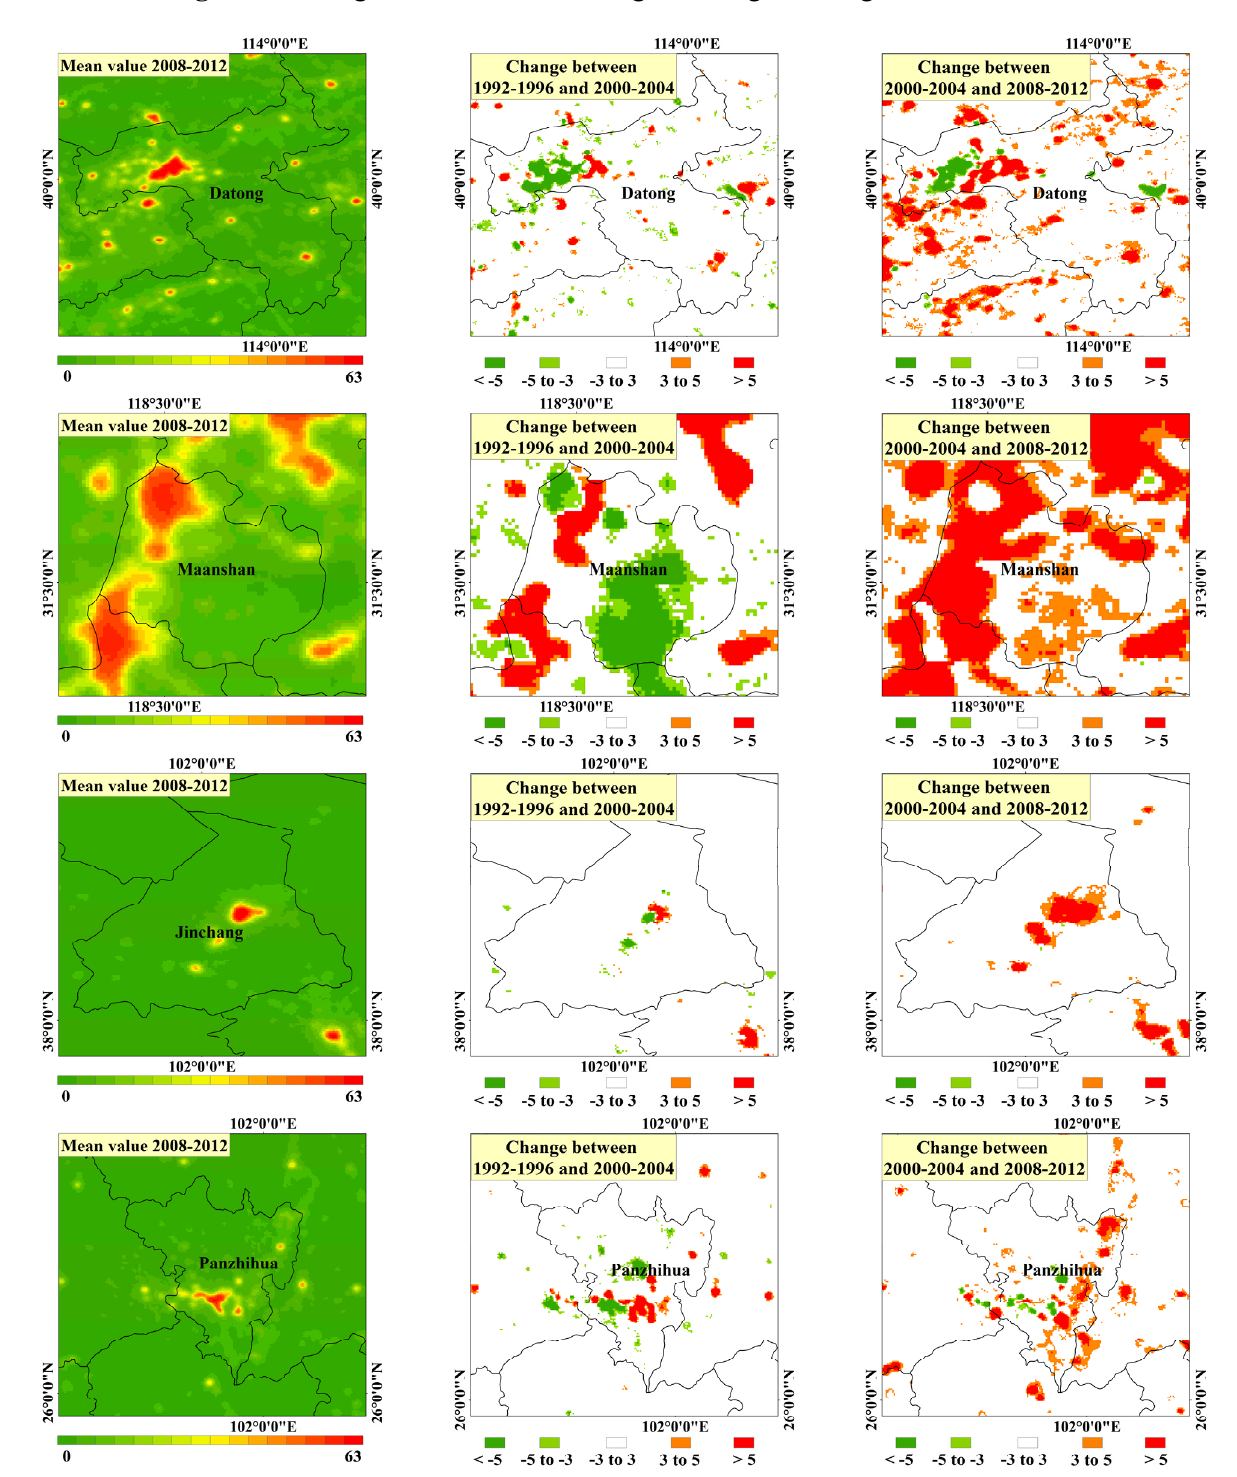
Figure 8. Change trends in detected nighttime light among industrial